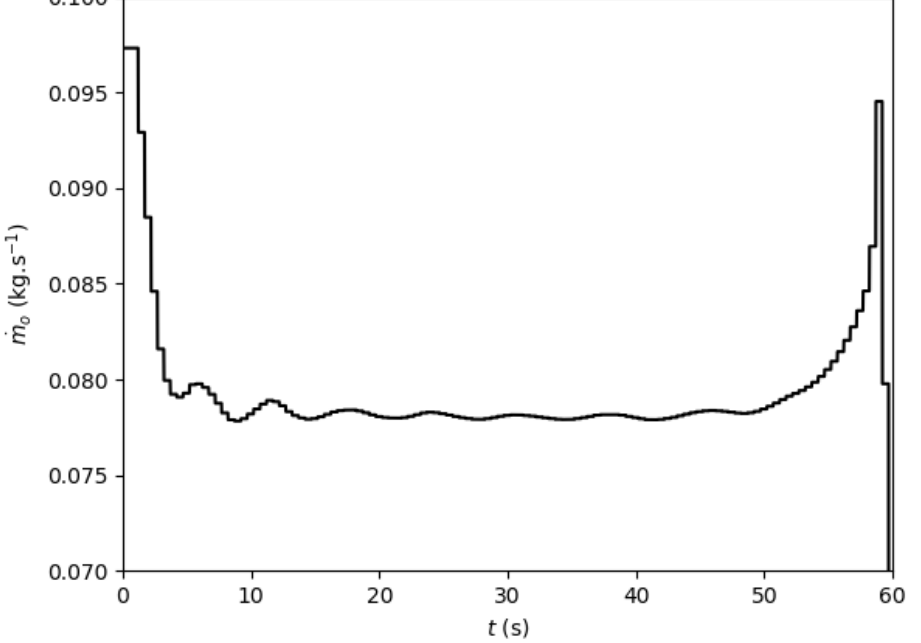
Figure A8. Oxidizer mass flow rate profile, feedback with downgraded regulation law, case